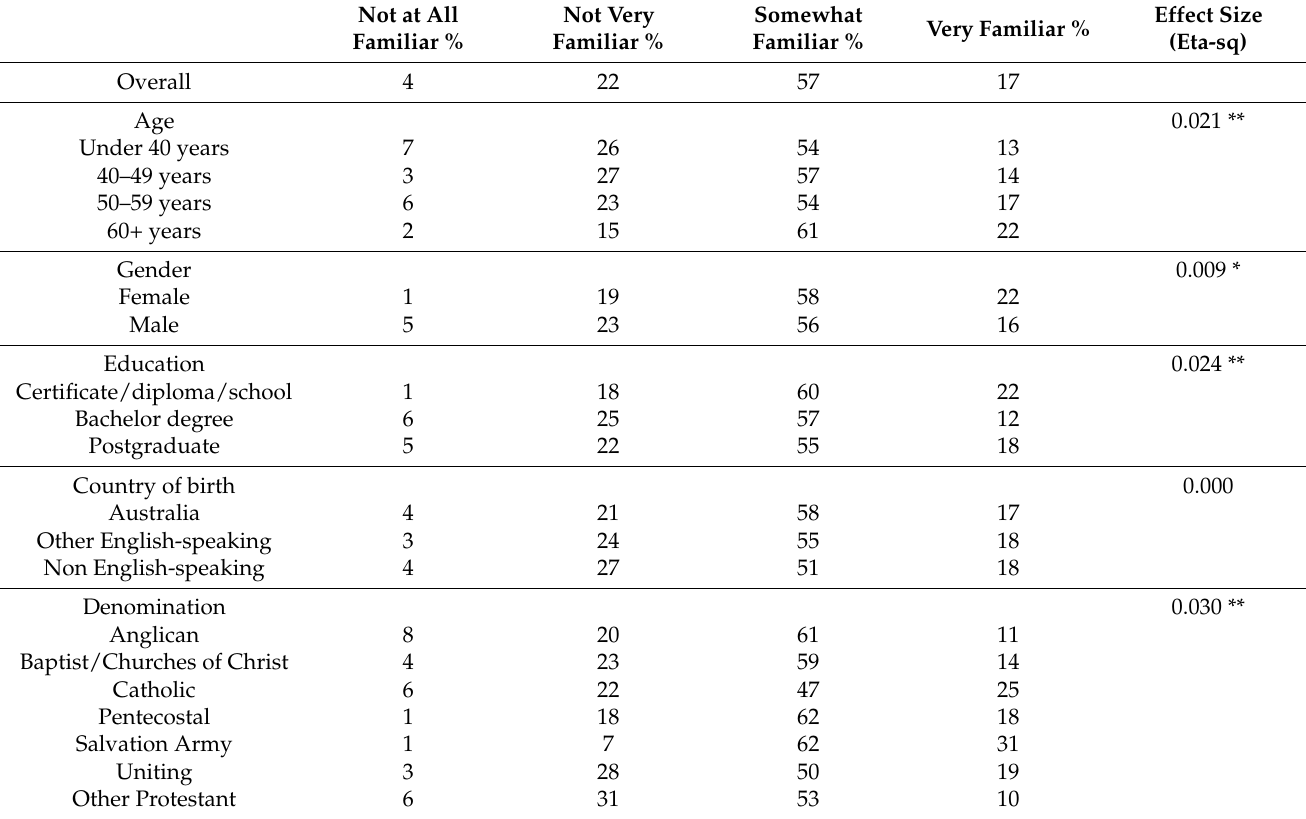
Table 9. Senior local church leader level of familiarity with DFV support services by demographics and denomination.